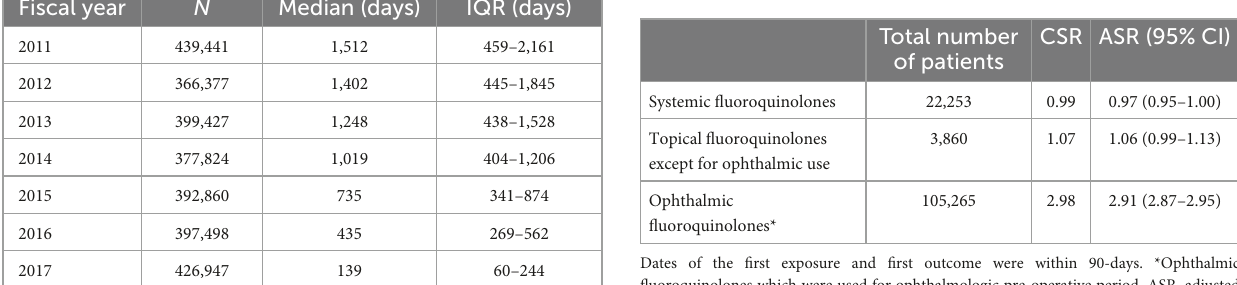
TABLE 1 Number of patients and summary statistics of cumulative prescription days of metformin-containing drugs for each sub-cohort. TABLE 2 Crude sequence ratio and adjusted sequence ratio of use-specific